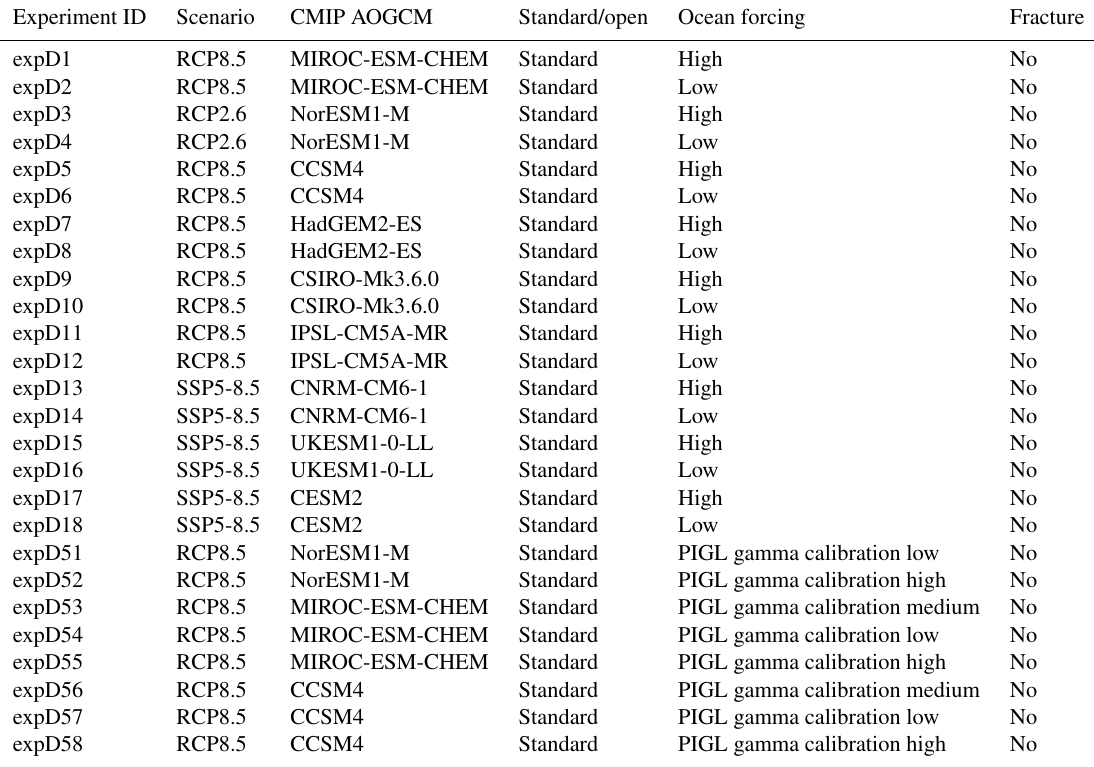
Table A3. Description of ISMIP6 Antarctica Tier 3 simulations to investigate impact of ocean